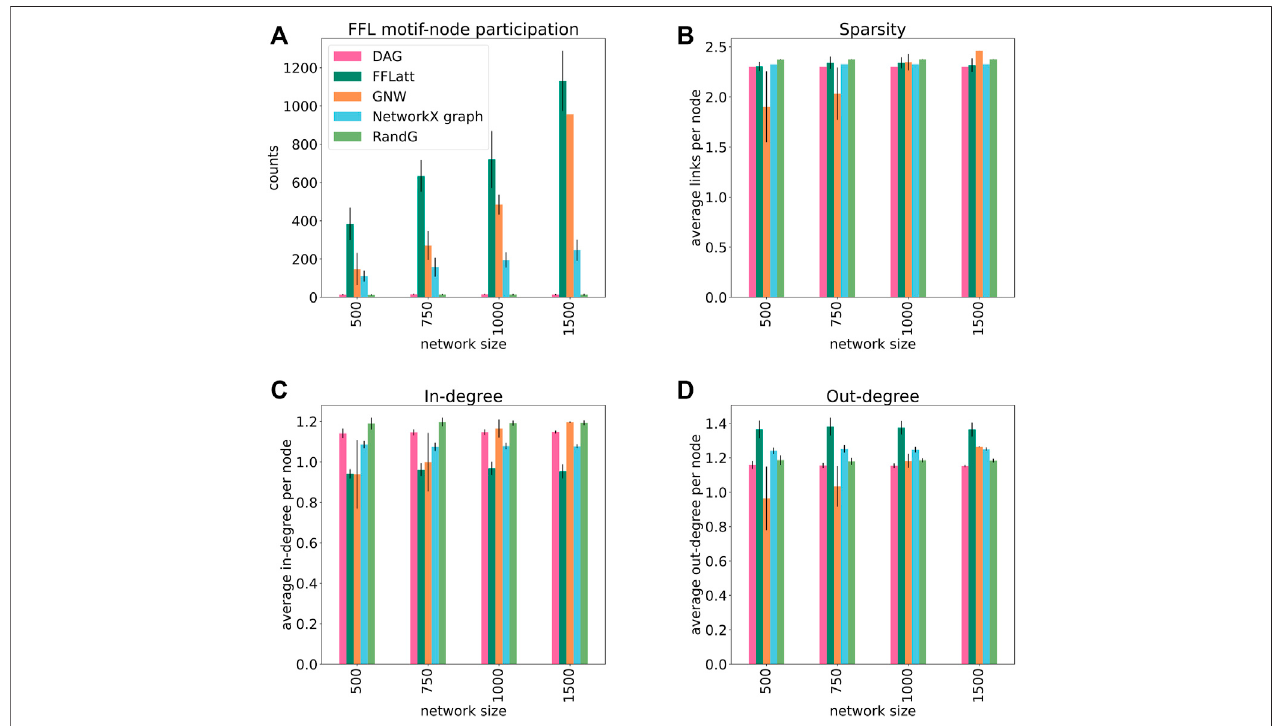
FIGURE 5 | Topological properties of simulated networks ( E. coli ). FFL motif node participation, average sparsity, in- and out-degree distribution in simulated networks. For FFL-motif node participation counts, up to three participations for each node were allowed (in different roles). Each data point was calculated as the average of ten different replicates of each network size. Error bars represent standard deviation.